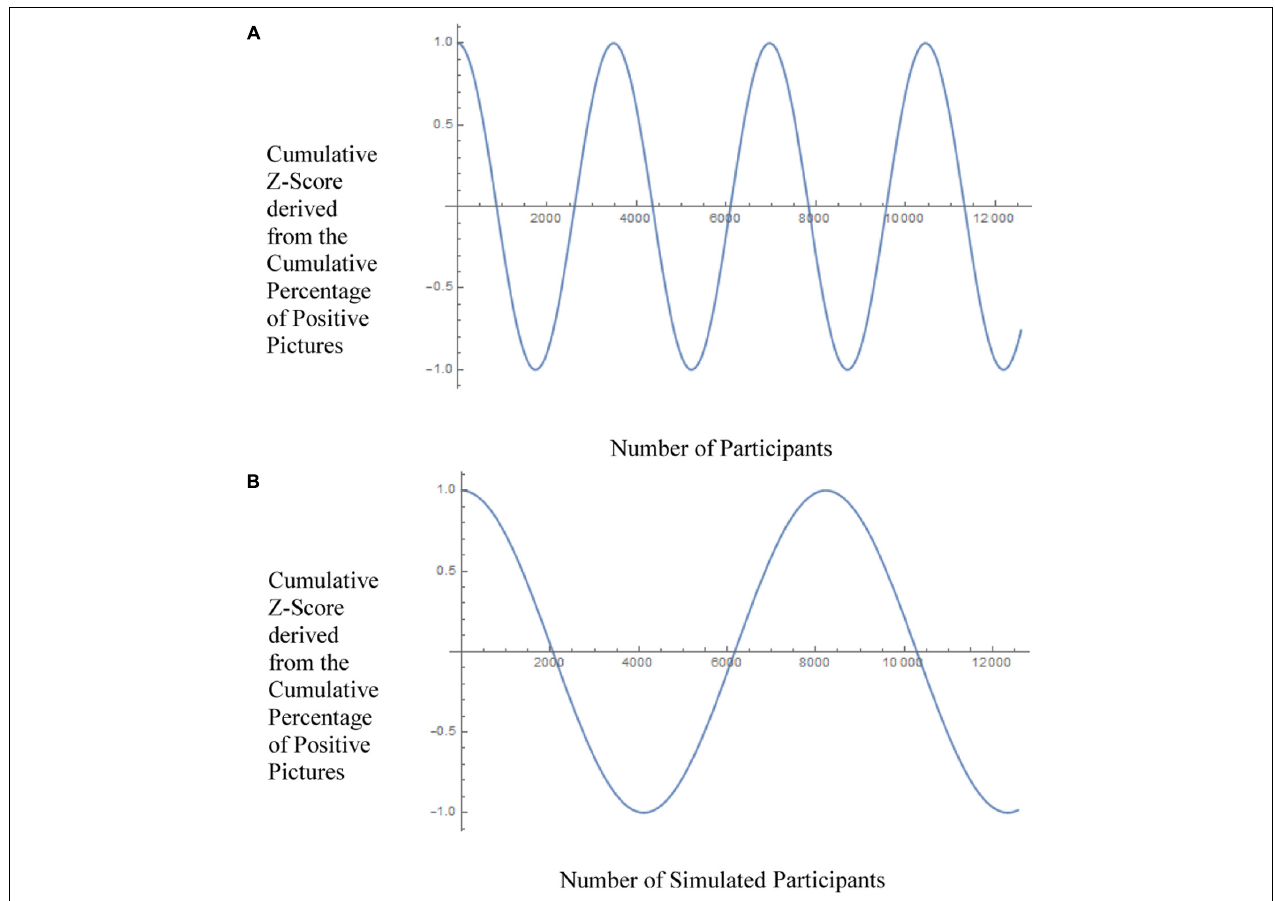
FIGURE 7 | Frequency of the oscillation for real (A) and simulated (B)